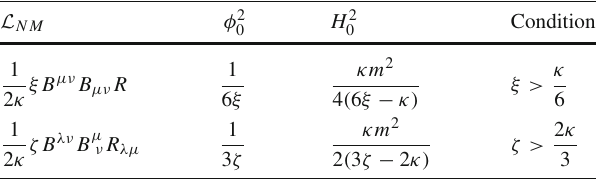
Table 1 The de-Sitter space solutions of φ and H , along with the con- dition on parameters ξ and ζ corresponding to R and R μν coupling terms respectively L NM